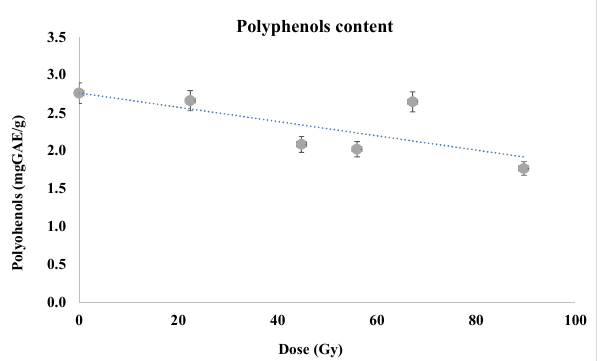
protect cells against the oxidative effects of ROS [34]. In the present study, polyphenol level was found to increase from 1.26 to around 2.08 mgGAE/g for proton dose around 60 Gy at the Bragg peak ( p ˂ 0.05), this variation being possibly correlated with the en- hancing of the MDA level presented above.